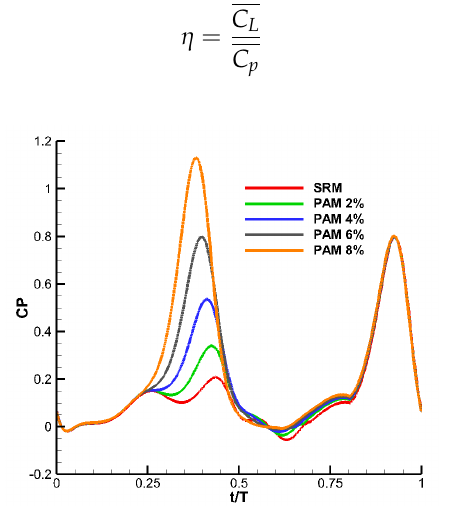
Figure 13. The time histories of power coefficient C P for partial advanced mode.